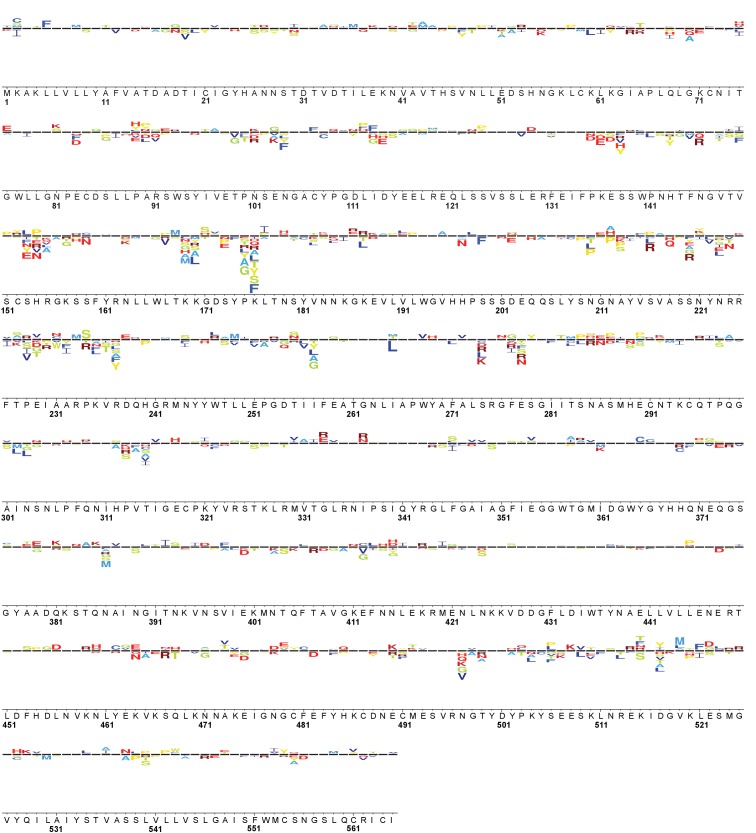
Full WSN HA sequence logo plot: Basal 39˚C vs. Basal 37˚C.Logo plot displays variants that behaved consistently across three biological replicates. Variants above the line (representative of selection on wild-type) were enriched at 39˚C relative to 37˚C in a basal environment; variants below the line were depleted at 39˚C. The wild-type WSN HA residue is shown below the corresponding logo, with the sites numbered below the wild-type sequence (based on sequential numbering of WSN HA). The size of the amino acid letter abbreviation is proportional to the diffsel for that amino acid variant, and all logo plots are plotted on the same scale.